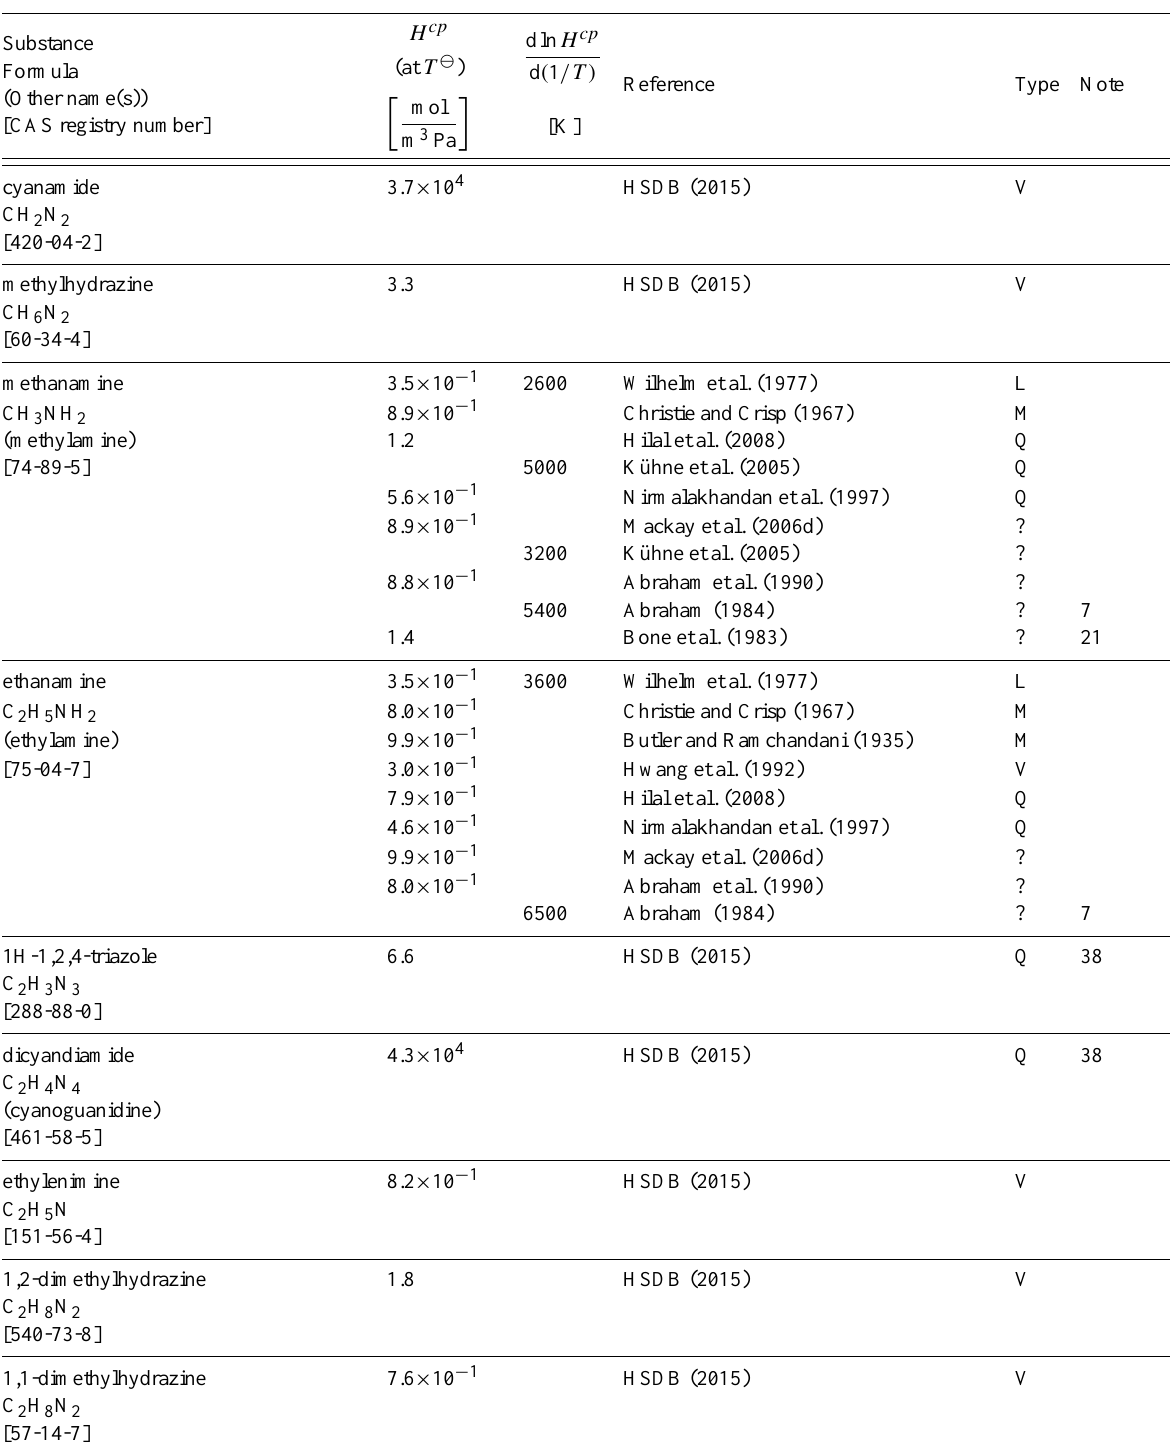
Table 6: Henry’s law constants for water as solvent